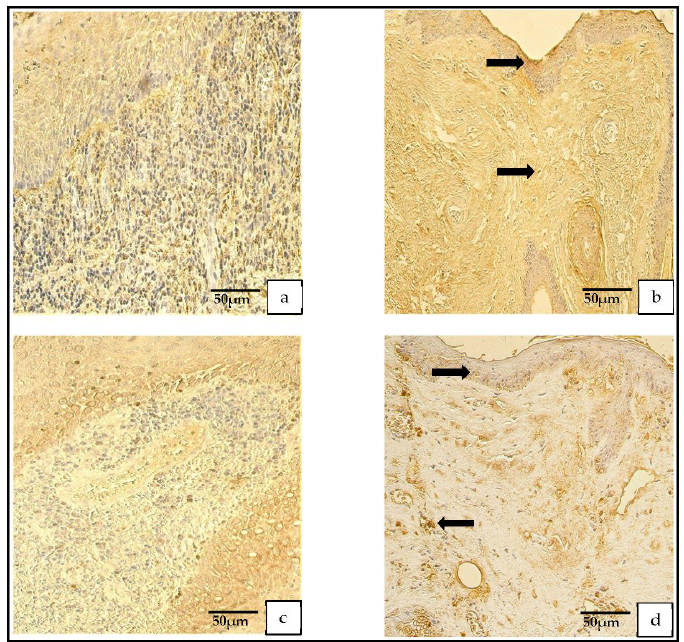
Figure 7. ( a – d ) Immunohistochemical micrographs. ( a ) Cholesteatoma . Moderate HβD– 2-positive cells in matrix and perimatrix, HβD– 2 IHC. ( b ) Skin . Few HβD– 2-positive cells in the epithelium (arrow) and occasional HβD– 2 - positive cells in the connective tissue (arrow), HβD– 2 IHC. ( c ) Cholesteatoma. Moderate-to- numerous HβD– 4-positive cells in matrix and few-to-moderate in perimatrix, HβD– 4 IHC. ( d ) Skin . A few HβD– 4-positive cells in the epithelium (arrow) and occasional HβD– 4 - positive cells in the connective tissue (arrow), HβD– 4 IHC.